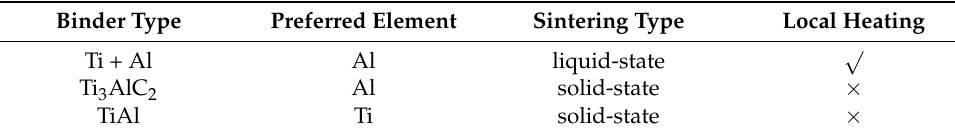
Table 2. Reaction mechanisms of several binders.